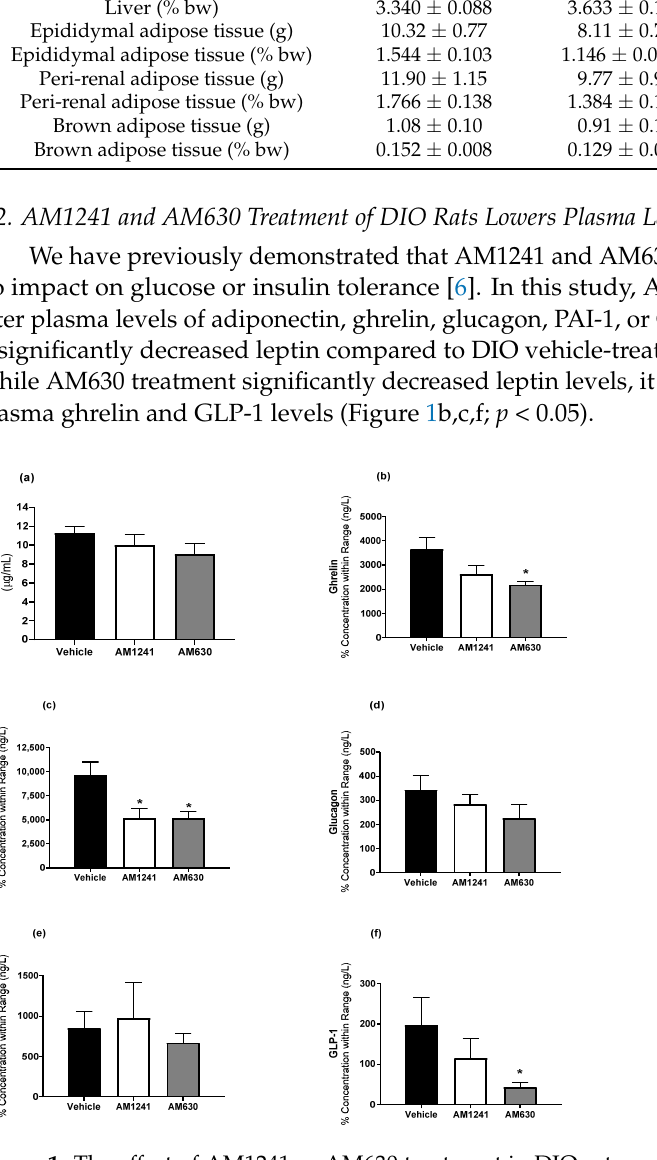
Figure 1. The effect of AM1241 or AM630 treatment in DIO rats on hormones involved in energy homeostasis. DIO rats were injected daily with AM1241 (3 mg/kg of body weight, ip), AM630 (0.3 mg/kg of body weight, ip), or vehicle for six weeks. Plasma ( a ) adiponectin, ( b ) ghrelin, ( c ) leptin, ( d ) glucagon, ( e ) PAI-1 or ( f ) GLP-1. All results are presented as a mean ± SEM from n = 8–9 (AM1241)-, n = 8–9 (AM630)-, and n = 8–9 (vehicle)-treated rats on an HFD (exception PAI n = 4, 6 and 7 for AM1241, AM630 and vehicle, respectively). Significance * p < 0.05 compared to